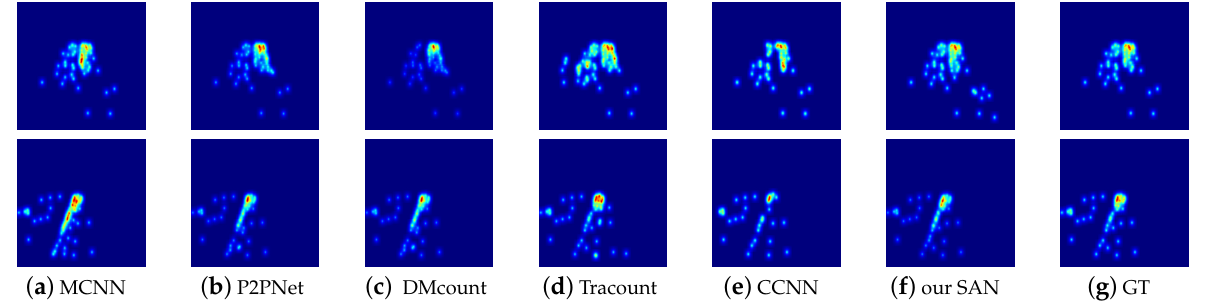
Figure 5. Qualitative comparisons with baselines and the ground truth (GT) on TRANCOS dataset: ( a ) MCNN, ( b ) P2PNet, ( c ) DMcount, ( d ) Tracount, ( e ) CCNN, ( f ) our SAN, and ( g )